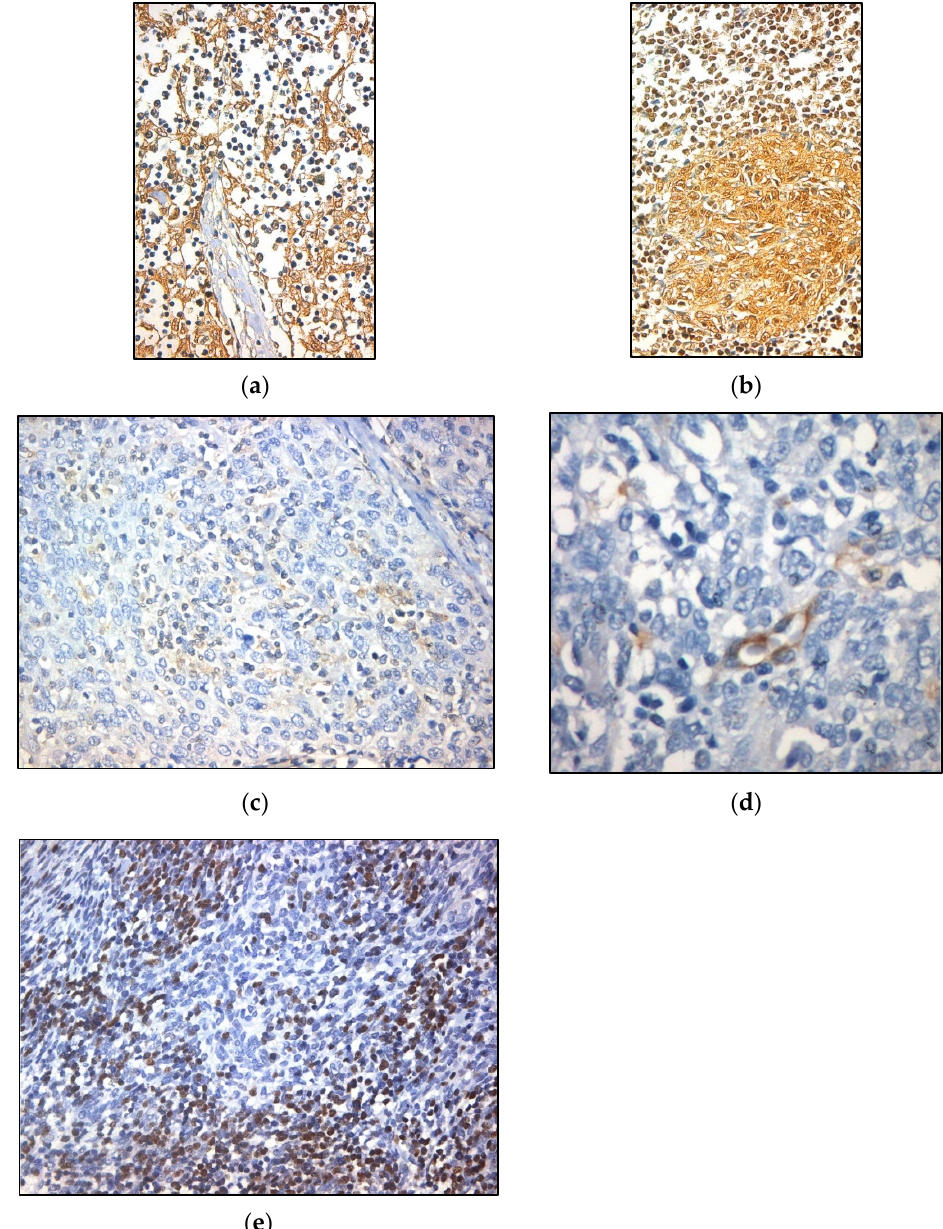
Figure 4. Immunohistochemical expression of EphB1 ( a , b ), EphB2 ( c ), EphB4 ( d ) and EphB6 ( e ).